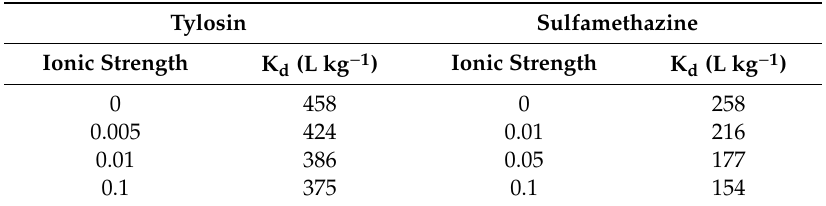
Table 4. E ff ect of ionic strength on the partition constant for the sorption of tylosin and sulfamethazine at pH = 4 (adapted from [93]).